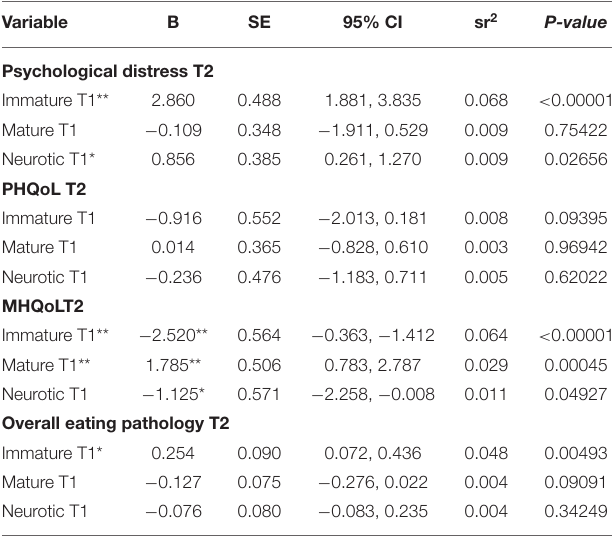
TABLE 3B | Influence of defence-style factors at T1 on T2 psychological distress, PHQoL, MHQoL, and overall eating